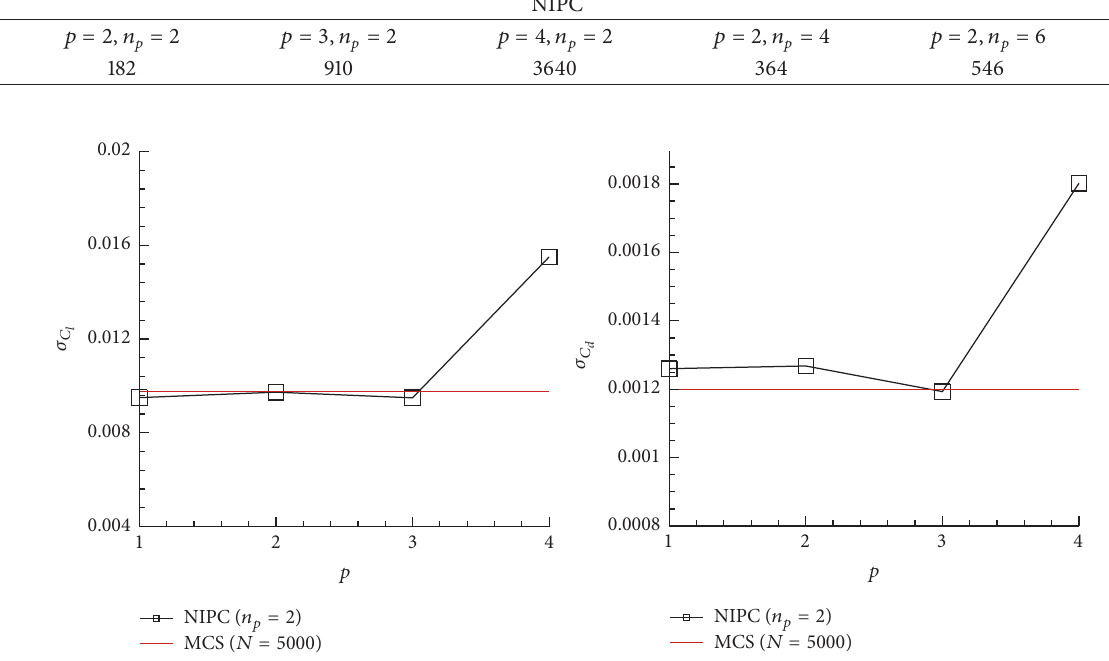
Figure 7: Standard deviation distribution of the aerodynamic coefficients with the order of NIPC.